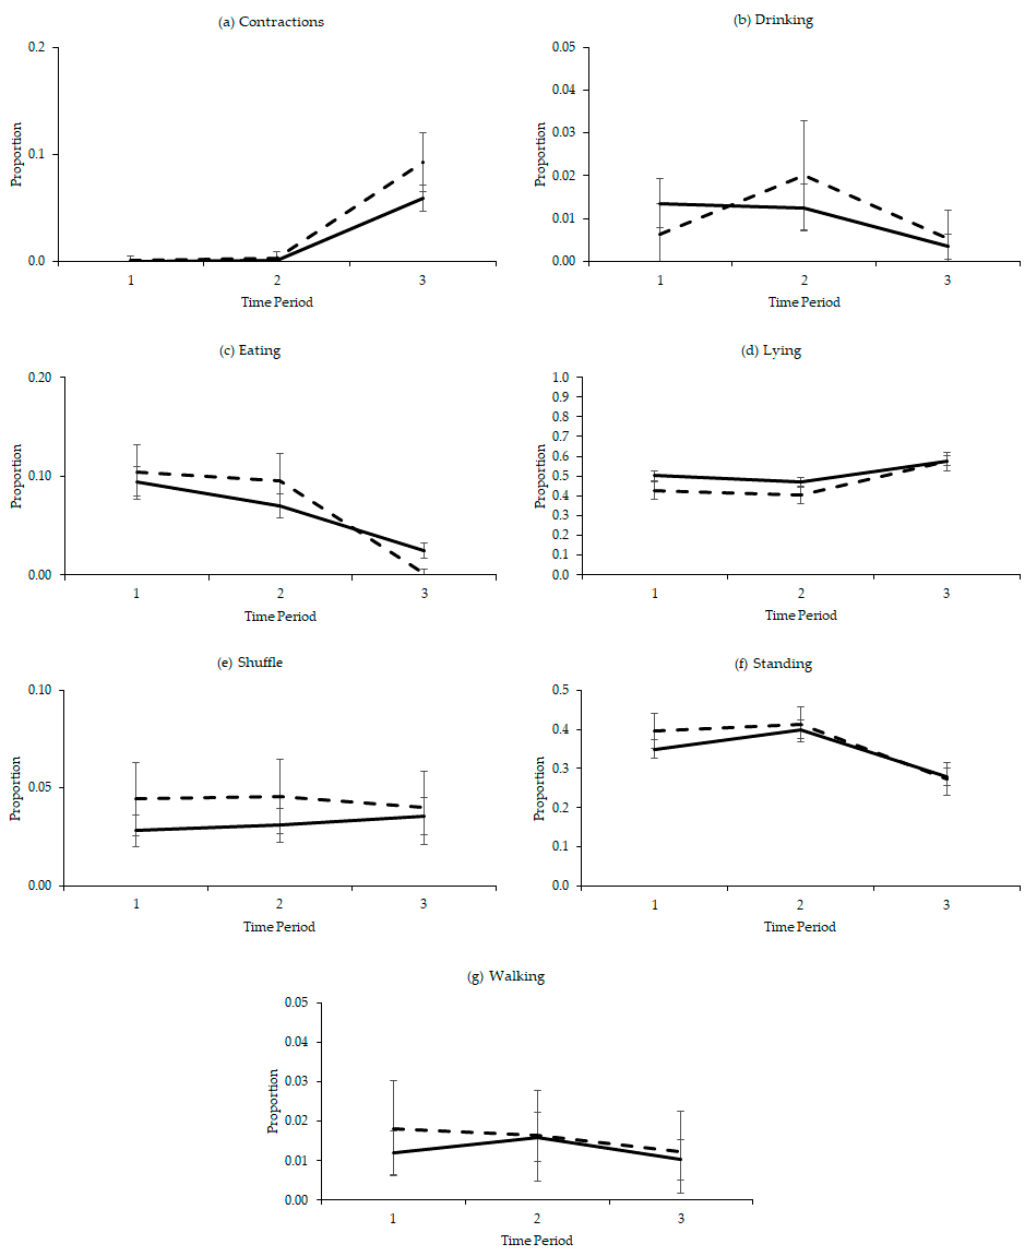
Figure 2. Predicted mean ( ± SEM) proportion of time that were ( a ) contractions, ( b ) drinking, ( c ) eating, ( d ) lying, ( e ) shuffle, ( f ) standing and ( g ) walking behavior for assisted (dashed line) or unassisted (solid line) dairy cow calvings ( n = 35) in time periods one to three, with period three ending with the birth.